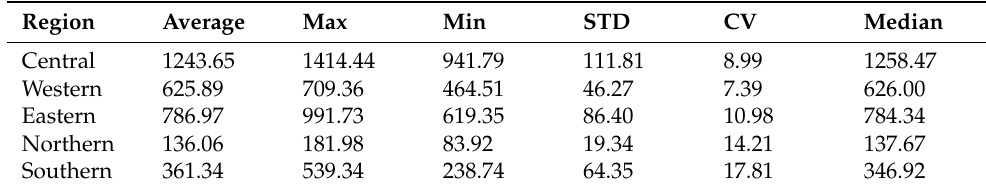
Table A2. Descriptive statistics for annual rainfall (in mm) for regions from TAMSAT data (1983